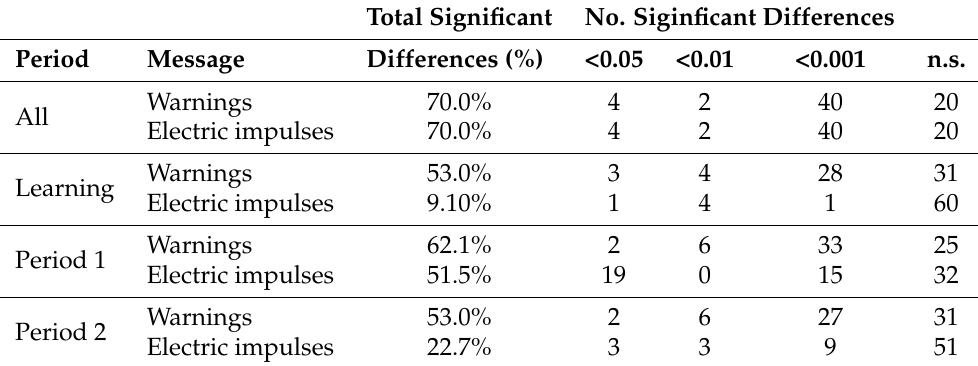
Table A2. Individual differences in the number of auditory warnings and electric pulses they received throughout the entire experiment, the learning period, period 1, and period 2, respectively. The percentage of pairwise comparisons that showed significant differences between the individuals along with the significance level of the pairwise comparisons.